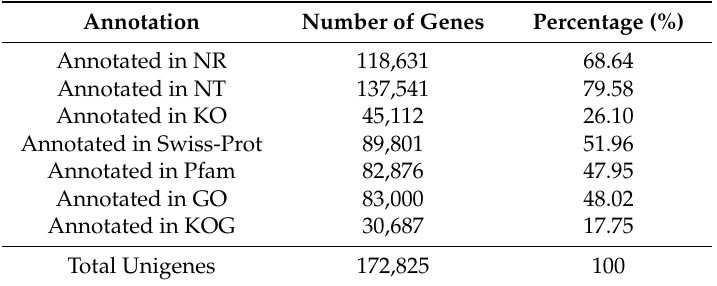
Table 2. Summary of annotations of the T. foenum-graecum